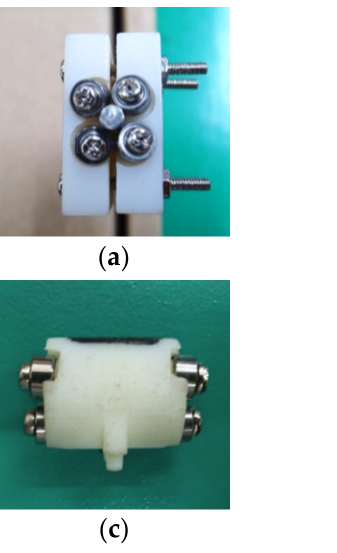
Figure 8. Designed and implemented prototypes of TLBS nuts: ( a ) Two-part body (weight of 5.3 g); ( b ) Single body (weight of 3.2 g); ( c ) One-piece preloaded structure with outside bearings (weight of 1.8 g); ( d ) One-piece preloaded structure with inside bearings (weight of 0.9 g).